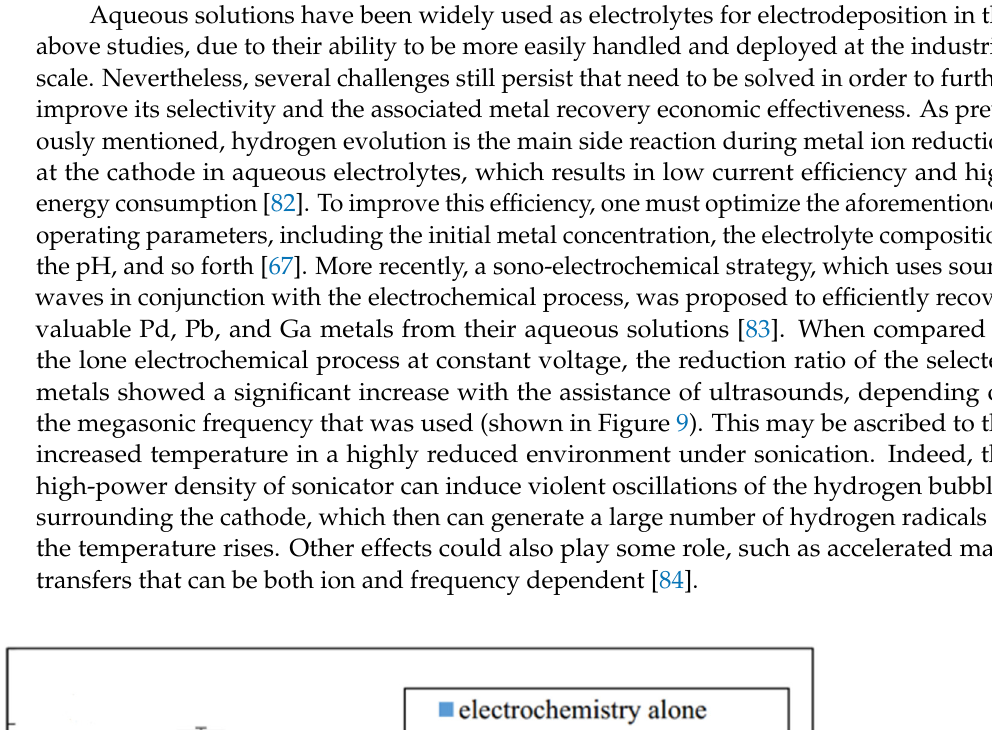
Figure 8. Schematic description of electrorefining process ( A ) and current density–cell voltage de- pendence for the electrorefining of copper ( B ). Reproduced with permission [16] . Copyright 2007, Wiley.